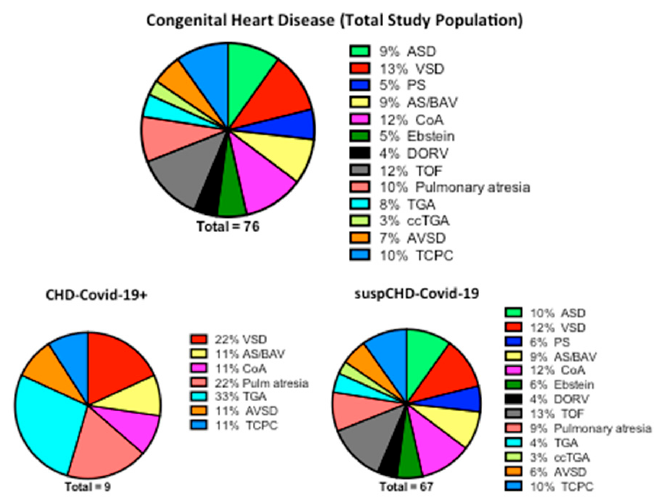
Figure 1. Congenital Heart Disease distribution on admission to high-volume Italian CHD centres with “clinically suspected” or “confirmed” COVID-19 diagnoses. CHD = Congenital Heart Disease; ASD = atrial septal defect; VSD = ventricular septal defect; PA = pulmonary stenosis; AS / BAV = aortic stenosis / bicuspid aortic valve; COA = coarctation of the aorta; DORV = double outlet right ventricle; TOF = tetralogy of Fallot; TGA = transposition of the great arteries; ccTGA = congenitally corrected transposition of the great arteries; AVSD = atrioventricular septal defect; TCPC = total cavopulmonary connection; CHD-Covid-19 + = confirmed diagnosis of COVID-19; suspCHD-Covid-19 = clinically suspected COVID-19 (no confirmation test available during the outbreak).